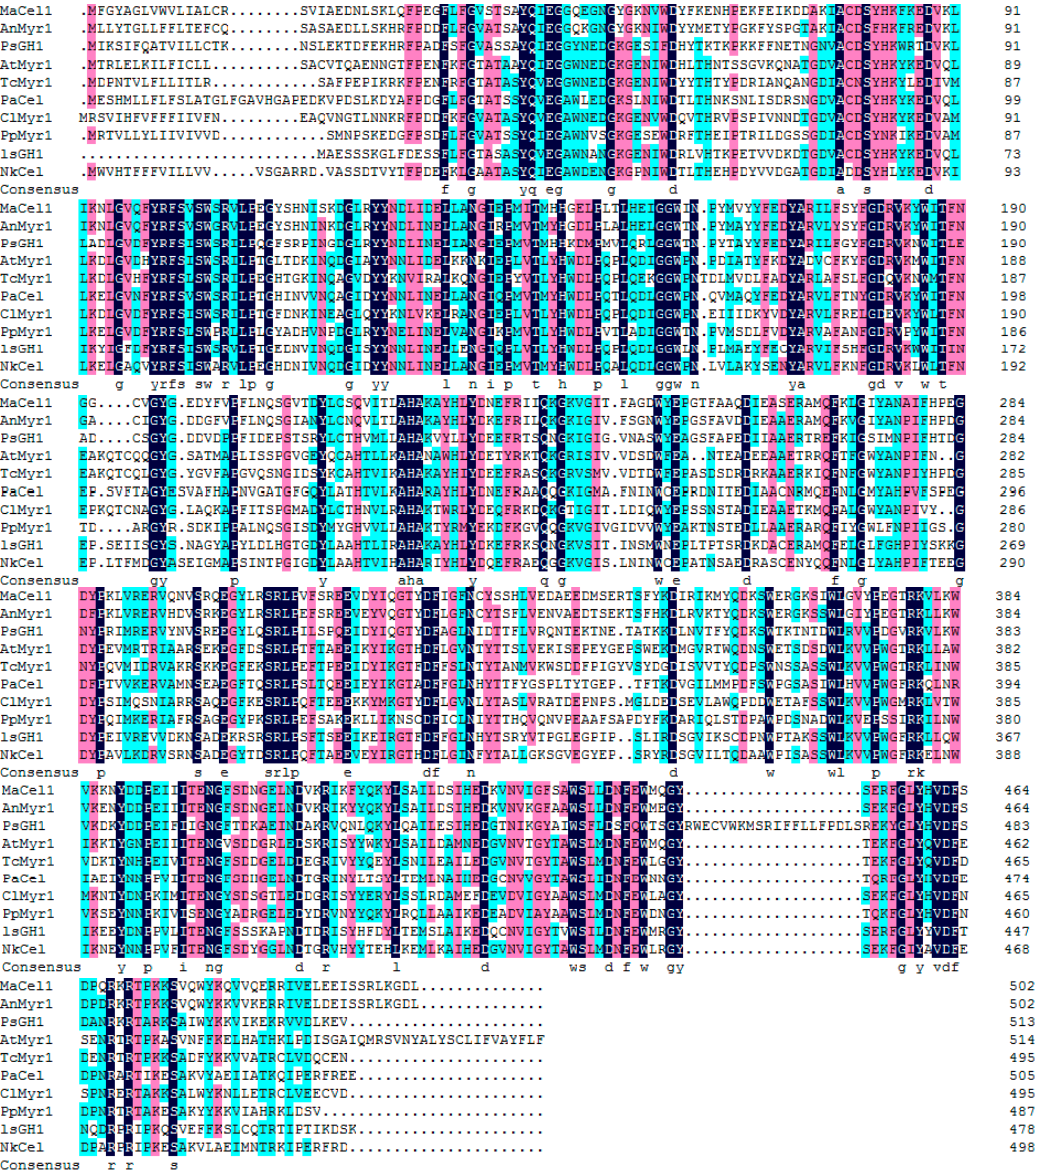
Figure 3. The amino acid sequences of MaCel1 genes and some insect cellulase genes. MaCel1 protein source and GenBank accession number: MaCel1 : M. alternatus (ATY36713); AnMyr1 : A. glabripennis (XP018565386); PsGH1 : Phyllotreta striolata (AHZ59658); AtMyr1 : Aethina tumida (XP019880470); TcMyr1 : Tribolium castaneum (XP966332); PaCel : Periplaneta Americana (AIA09348); ClMyr1 : Chrysomela lapponica (XP966332); PpMyr1 : Fireflies: Photinus pyralis (XP966332); LsGH1 : Laodelphax striatellus (RZF43906); NkCel : Neotermes koshunensis (BAB91145).